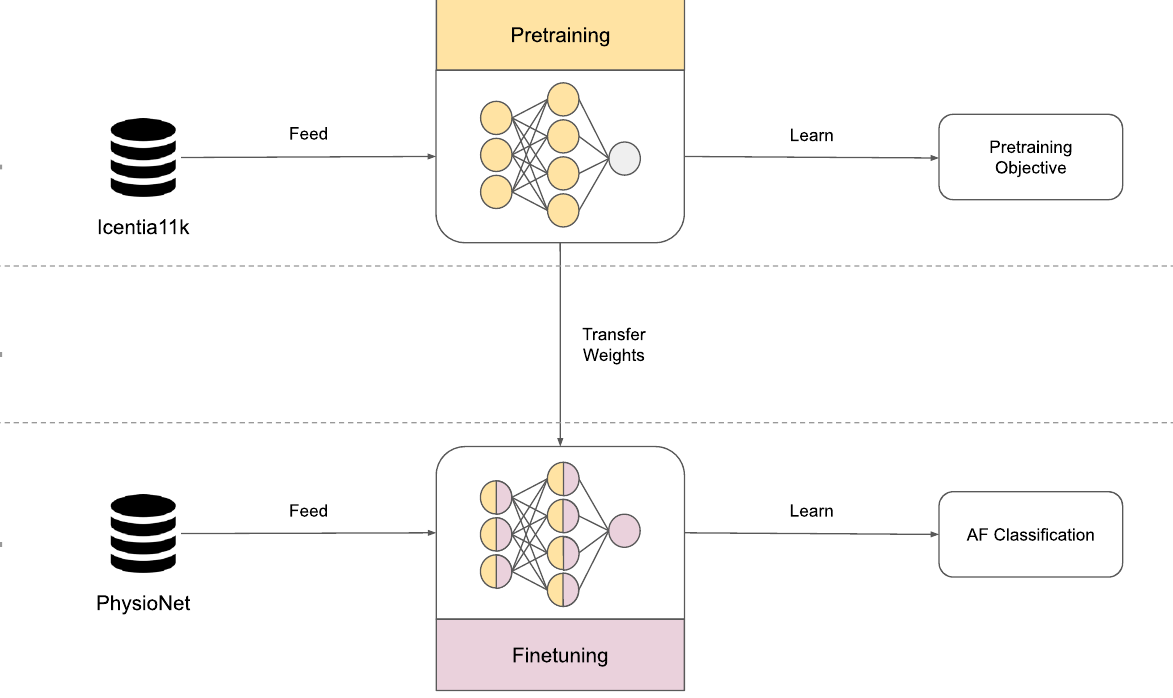
Figure 1. Visualization of transfer learning in this work. The process is divided into 3 steps: (1) deep convolutional neural network (CNN) is pretrained on the Icentia11K 5 data set for a selected pretraining objective, e.g. classification of heart rate; (2) the pretrained weights are used as initial weights of a new CNN; (3) this CNN is finetuned on the PhysioNet/CinC Challenge 2017 7, 8 data set to classify Atrial Fibrillation